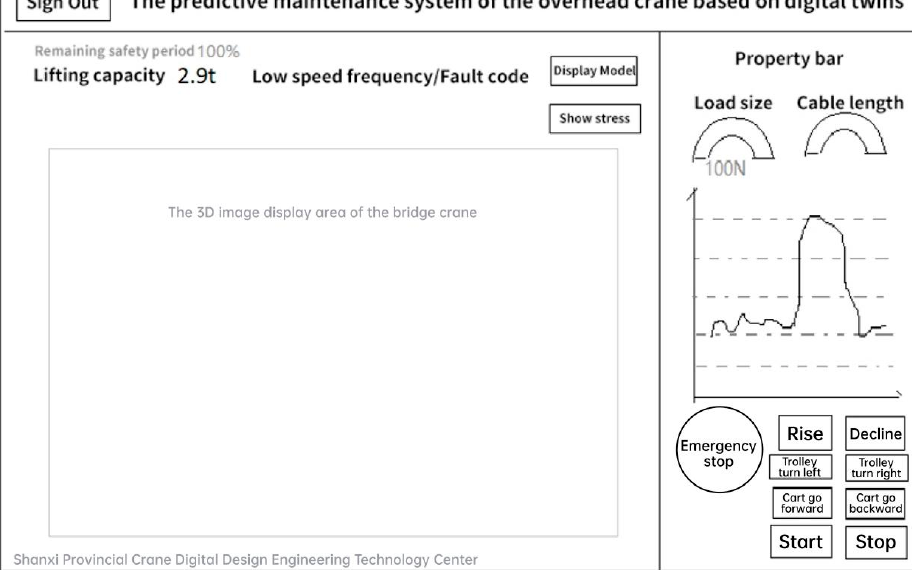
Figure 3. The e ff ect of the preliminary software prototype. Figure 3. The effect of the preliminary software prototype.